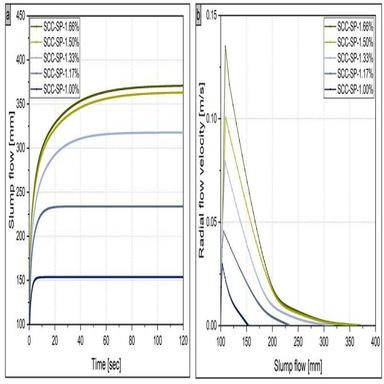
Slump flow development over time (a) and slump flow versus radial flow velocity (b) of the SCC mixes with varying SP content.